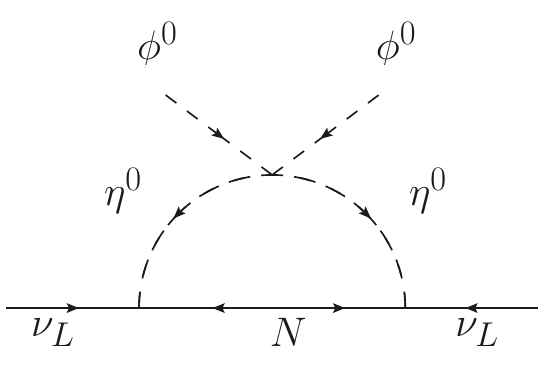
Figure 1 . The one-loop neutrino mass generation in Scotogenic